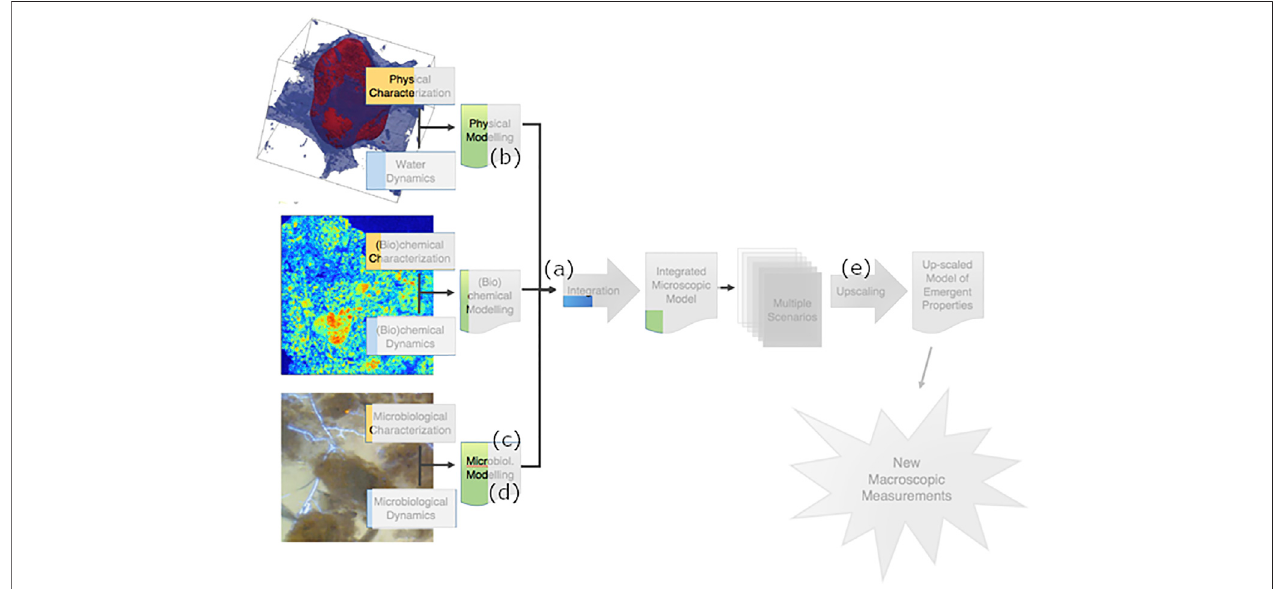
FIGURE1| Schematicrepresentationoftheresearch fl owchartontheemergentpropertiesofsoils,asoutlinedbyBaveyeetal.(2018).Itconsistsofasequenceof steps, leading from a characterization of the physical, (bio)chemical, and biological properties and dynamics at the microscale, onward to an upscaled macroscopic model,and fi nallytotheultimategoalofidentifyingmacroscopicmeasurementsthatcanbecarriedoutroutinely.Theun-shadedpartsofthedifferentblocksconstituting the fl owchartcorrespondtoBaveyeetal.(2018)estimateoftheprogressachievedoneachstep.TheletterlabelsindicatewherethearticlesofthepresentRThave made the most signi fi cant contribution. These labels correspond respectively to the articles by (A) König et al., (B) Rupp et al., (C) König et al., (D) Pagel et al., and (E) Almquist.